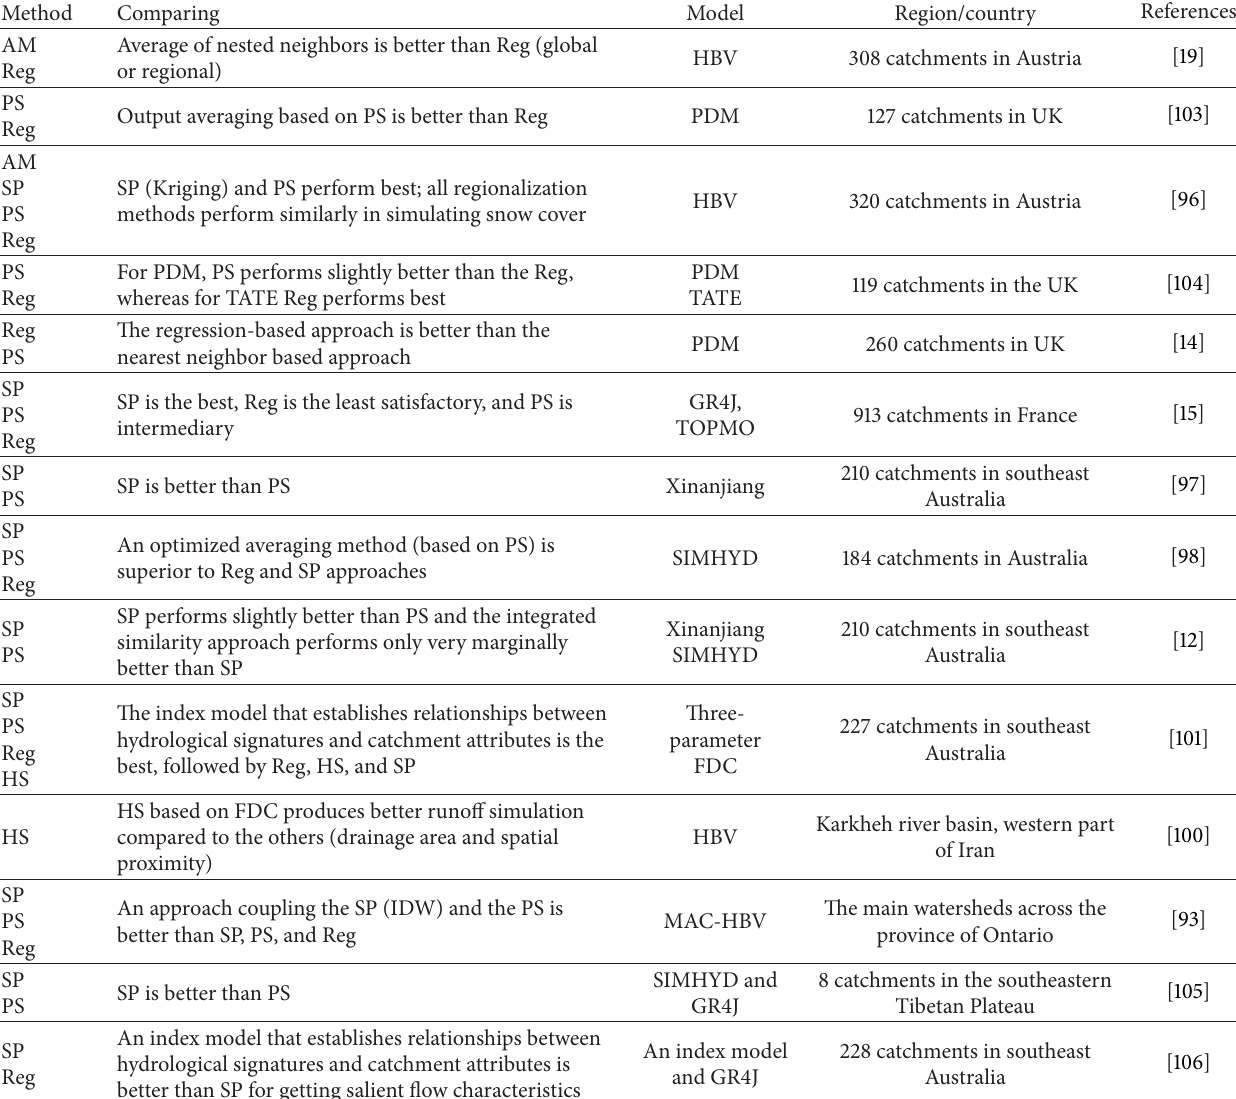
Table 2: Summary of regionalization approaches conducted using large